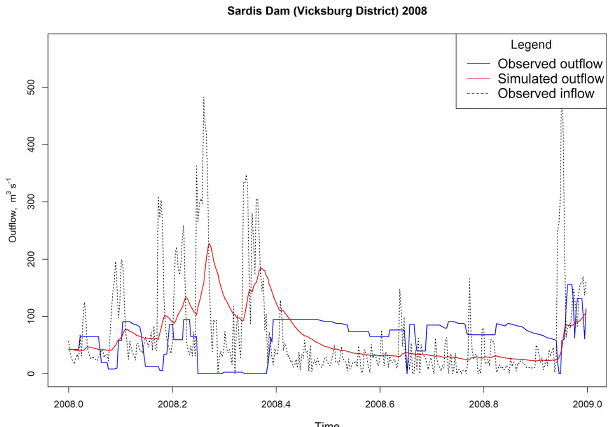
Figure 7. Hydrographs of observed inflow and outflow versus simulated outflow with the highest KGE value at Sardis Dam (Döll method k rd = 0 . 90). KGE comparing observed inflow and outflow =− 0 . 34; KGE comparing simulated and observed out- flows =